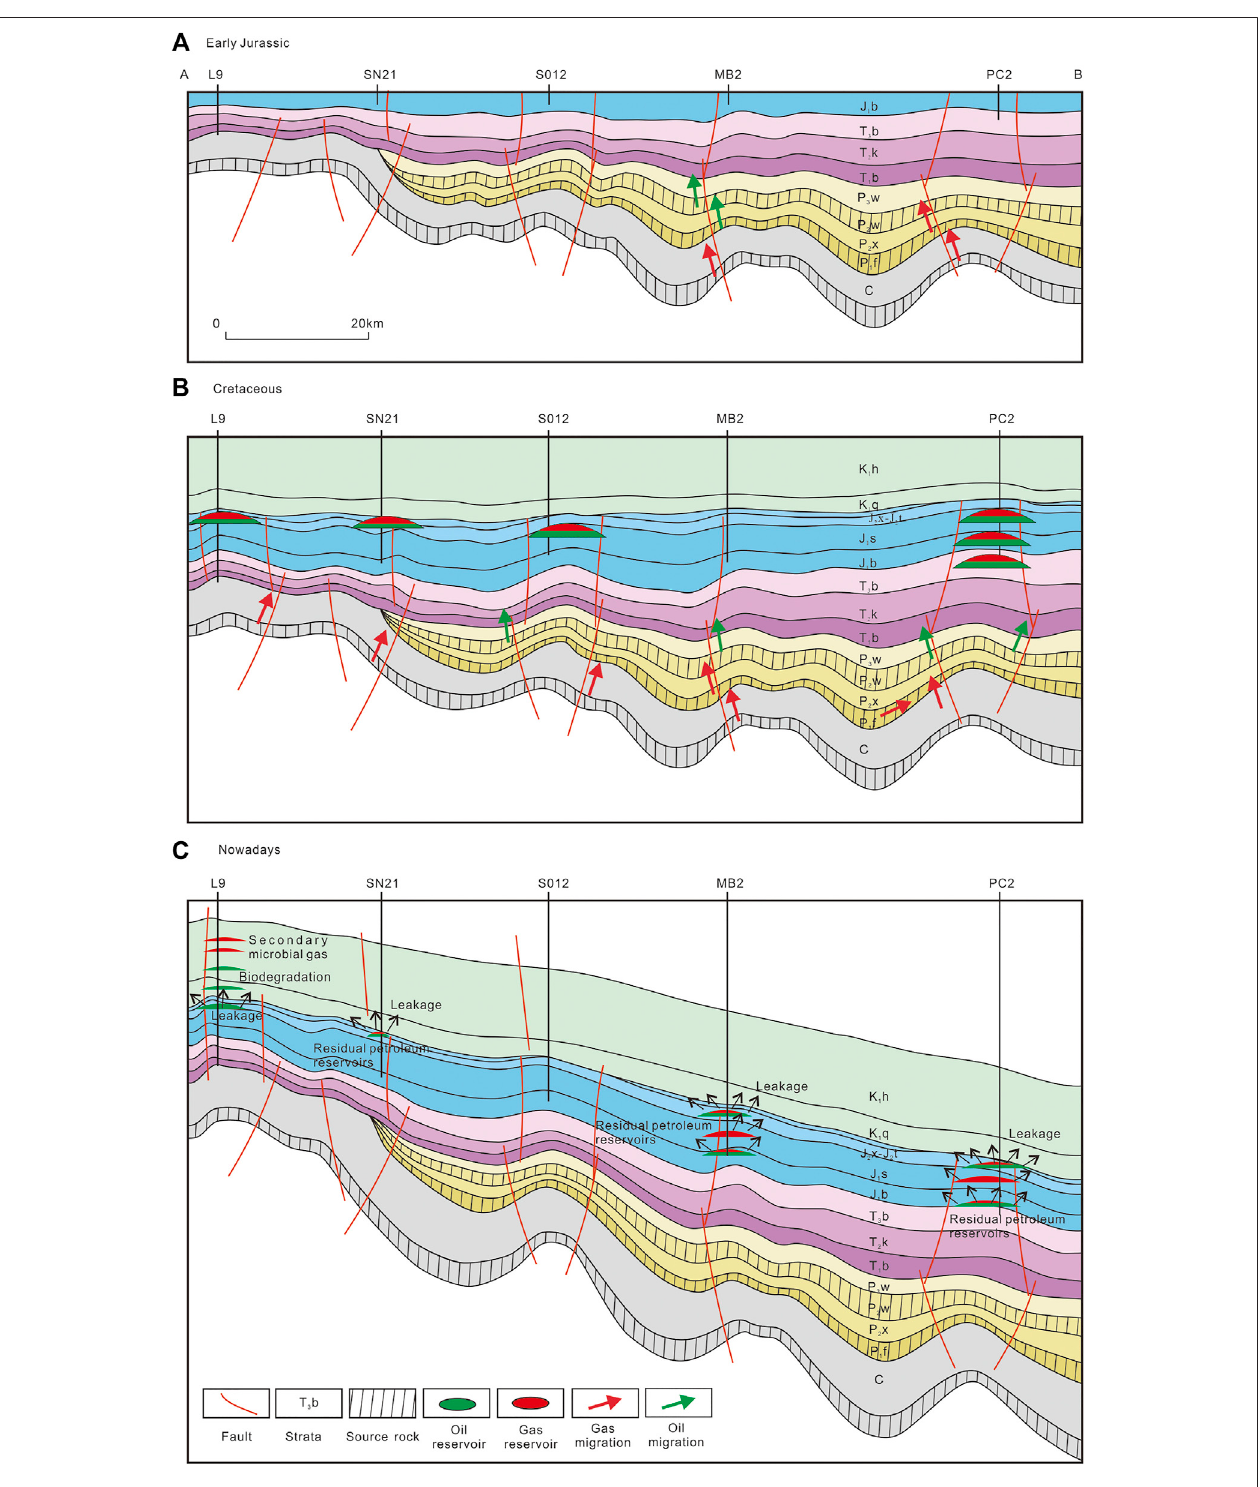
FIGURE 13 | Accumulation model of natural gas in (A) early Jurassic, (B) Cretaceous, and (C) nowadays in the hinterland of Junggar Basin.